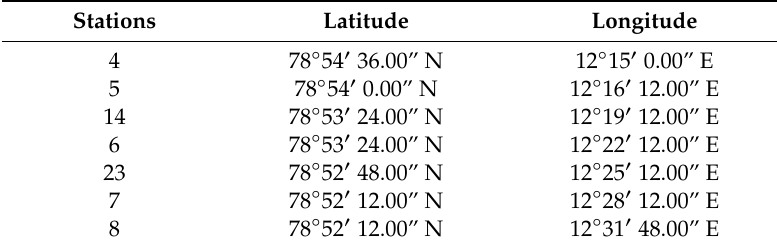
Table 1. Geographical coordinates of the studied